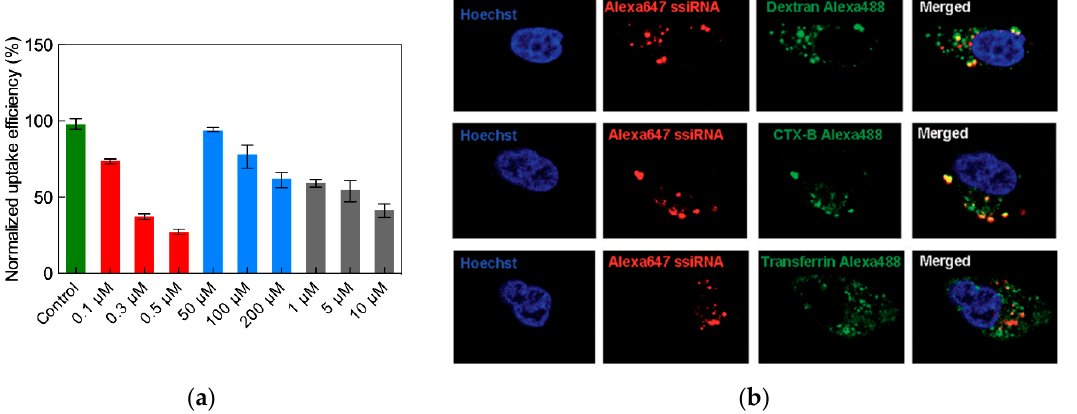
Figure 15. ( a ) E ff ect of cytochalasin D (a macropinocytosis inhibitor, red bars), genistein (a caveolae-mediated endocytosis inhibitor, light blue bars), and chlorpromazine (a clathrin-mediated endocytosis inhibitor, gray bars) on the uptake of Alexa 647-labelled A 5 / T 5 ssiRNA / G 5 TEA-core dendrimer nanoparticles by PC-3 cells. Values are normalized to Alexa 647-labeled ssiRNA / G 5 TEA-core dendrimer nanoparticles uptake in the absence of any inhibitor. ( b ) Colocalization of the Alexa 647-labelled A 5 / T 5 ssiRNA / G 5 TEA-core dendrimer nanoparticles with di ff erent endocytosis biomarkers: Top panel, dextran (macropinocytosis biomarker); middle panel, cholera toxin B (caveolae-mediated endocytosis biomarker); bottom panel, transferrin (clathrin-mediated endocytosis